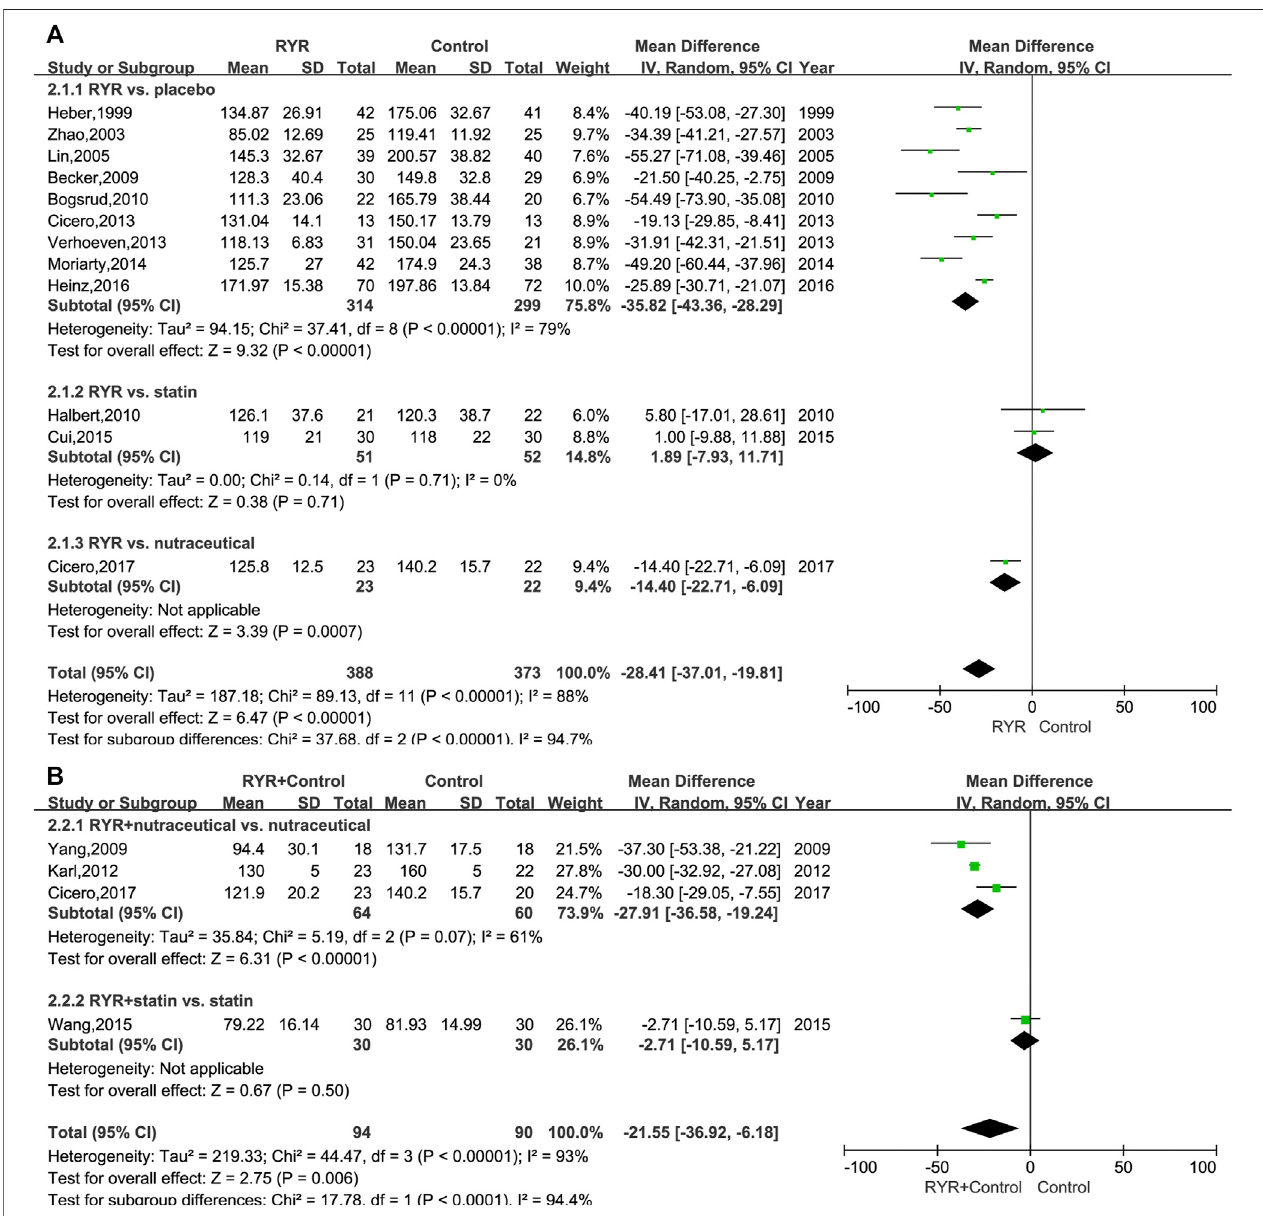
FIGURE2|(A) Forest plotofLDL-C betweenRYR alone and control groups. (B) Forestplot ofLDL-C between RYRin combination and controlgroups. (RYR:red yeast rice; LDL-C: low density lipoprotein cholesterol).